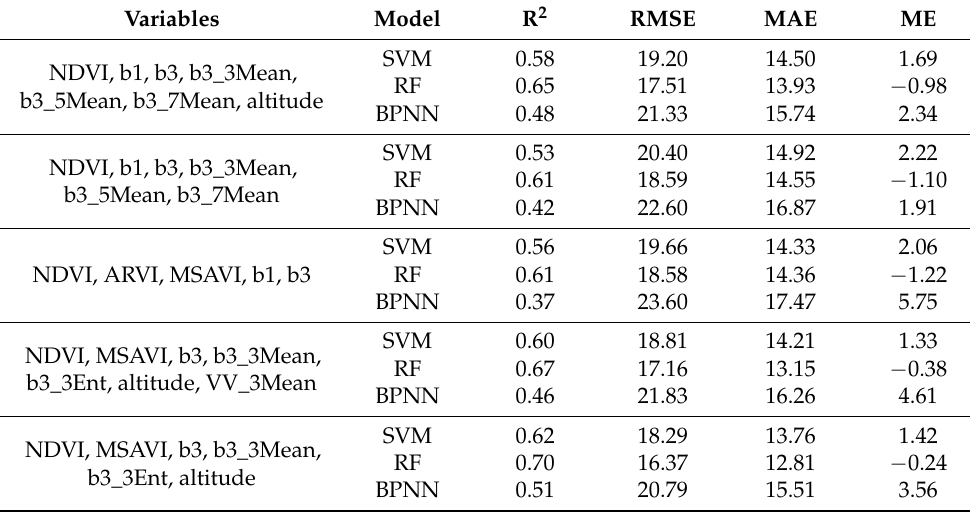
Table 5. Trial results of variable